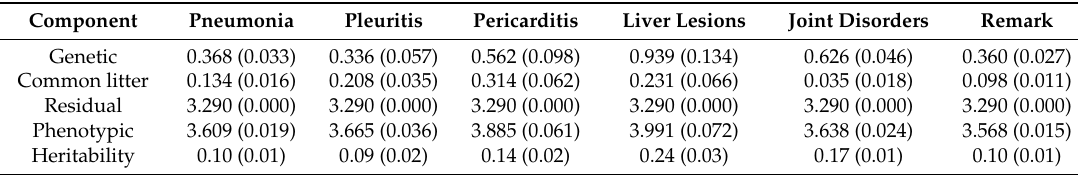
Table 2. Variance component estimates and heritability.